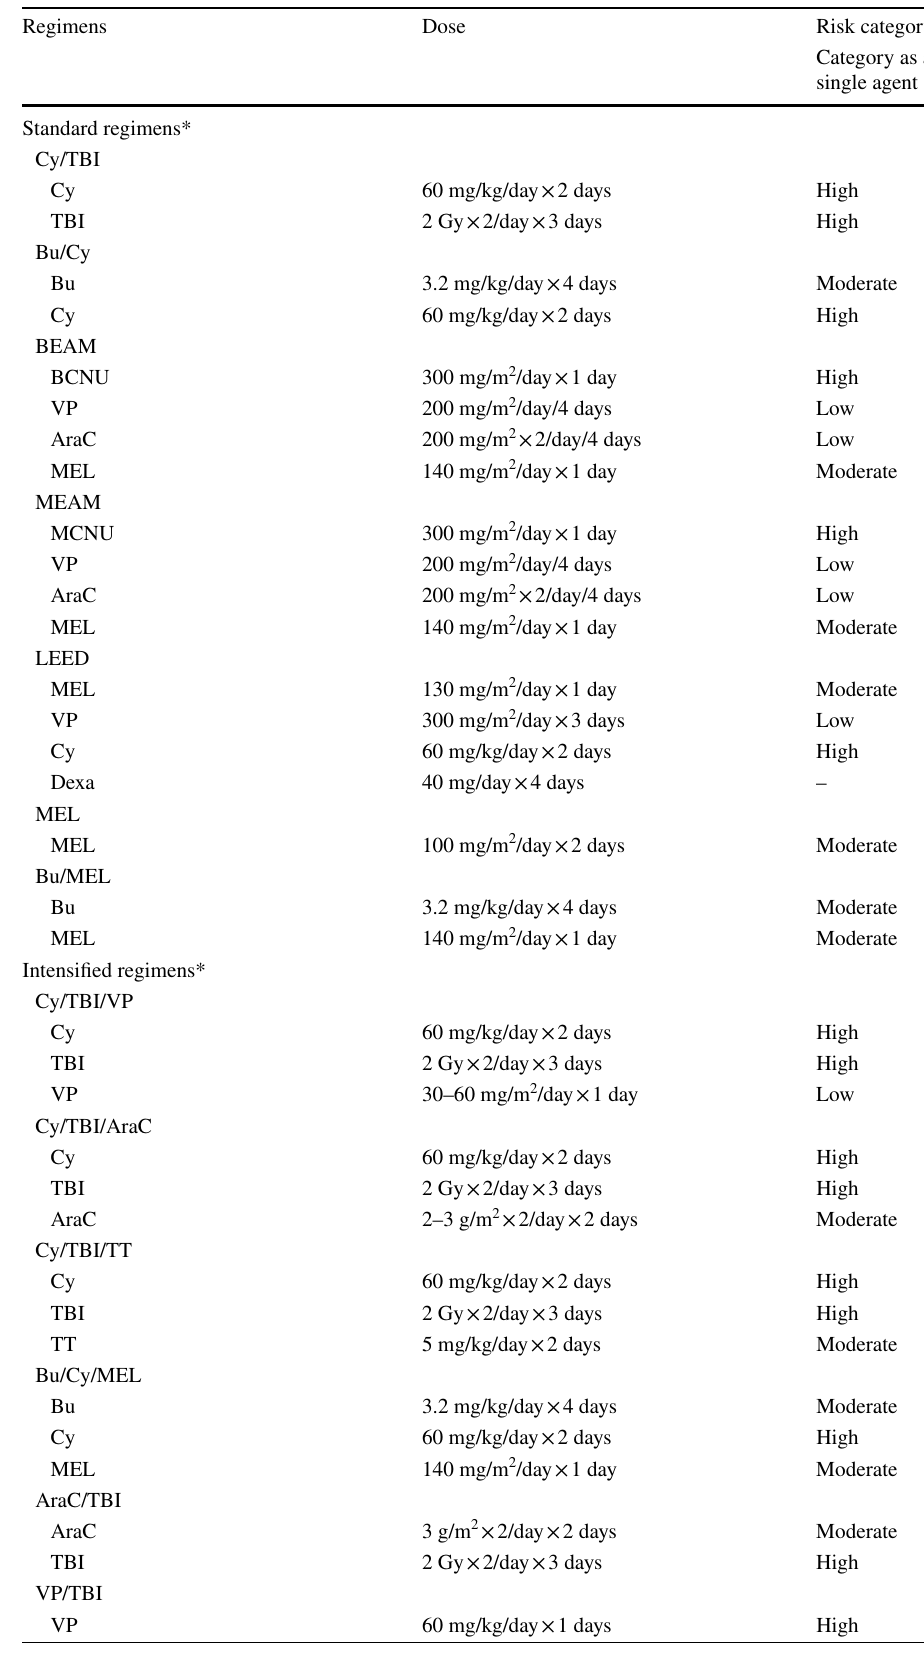
Table 2 Emetic risk of conditioning regimens according to